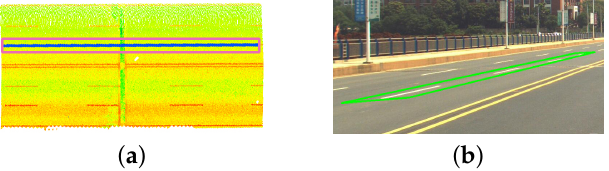
Figure 15. An example of mapping a candidate lane line. ( a ) In the colored point cloud, the blue line is a candidate lane line while the pink box is the 1m wide buffer. ( b ) The green box is the mapped buffer guided by the LiDAR